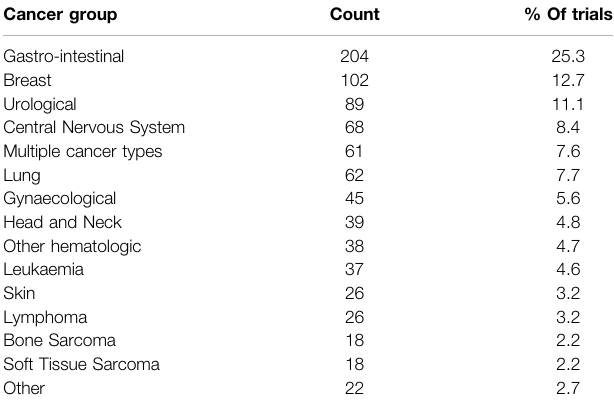
TABLE 2 | Distribution of trials by cancer group. Cancer group Count